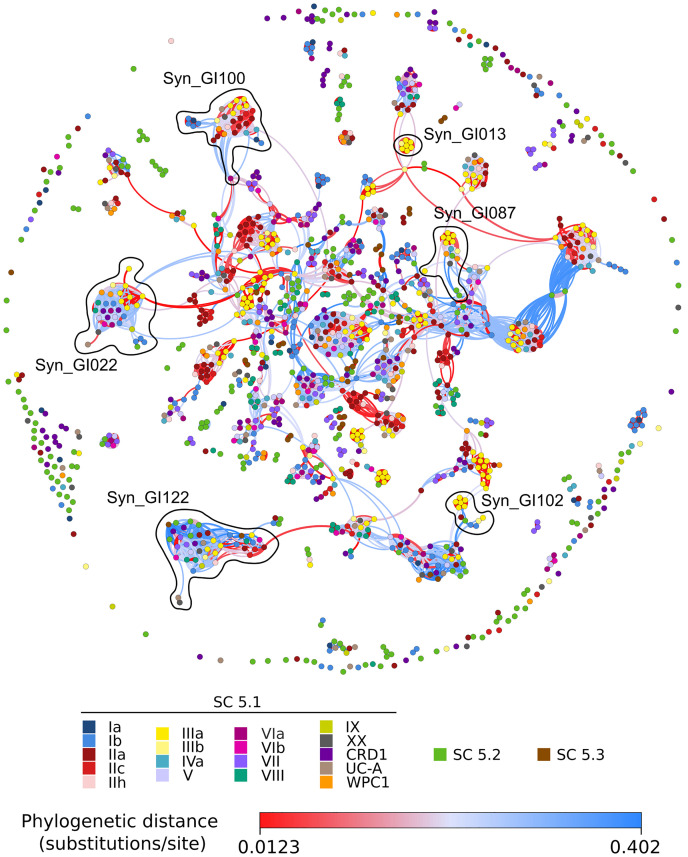
Same as Figure 6 but for marine Synechococcus/Cyanobium strains. The gene and genomic island composition of each module is described in Supplementary Table S7.